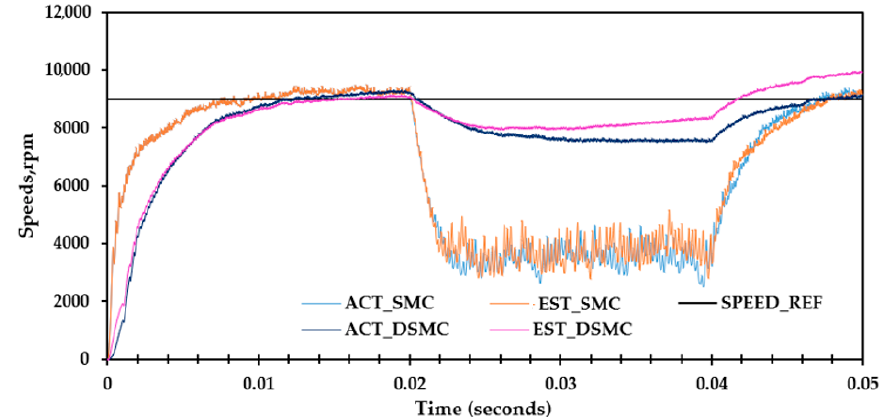
Figure 24. Changes in the supply voltage. [Note: ACT_SMC: actual speed under sliding mode controller; EST_SMC: estimated speed under sliding mode controller; ACT_DSMC: actual speed under dynamic sliding mode controller; EST_DSMC: estimated speed under dynamic sliding mode controller; SPEED_REF: reference speed].